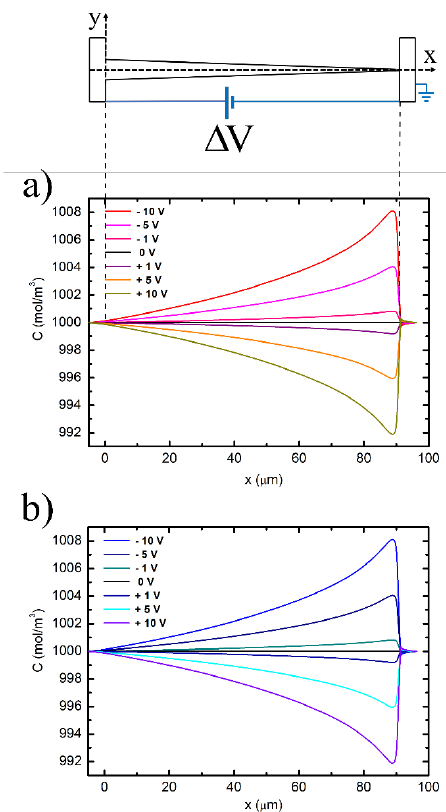
Figure 2. K + ( a ) and Cl − ( b ) ion concentration along the longitudinal section of the funnel and nanochannel as a function of the applied voltage between the reservoirs (C Bulk = 1 M = 10 3 mol/m 3 ).